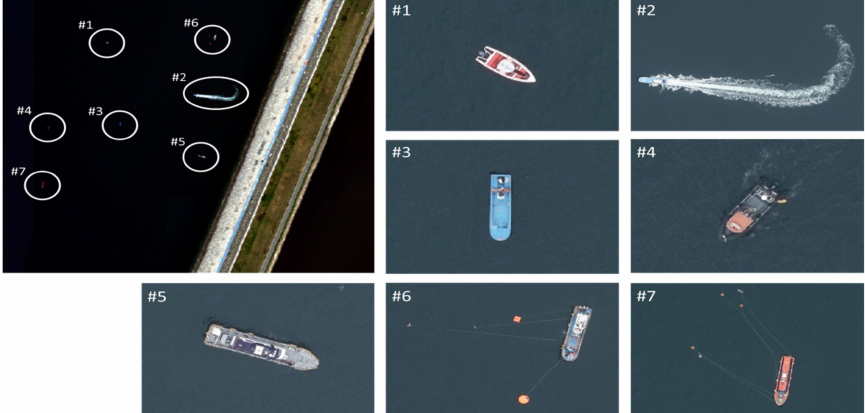
Figure 4. DMC images of small vessels and objects on seawater used in the experiment. Seven small vessels, #1 to #7, were used for the experiment; overboard from vessels #6 and #7, life-saving appliances, and a human mannequin are floated. The numbers (#1 to #7) corresponding to each target object are used consistently in the figures that